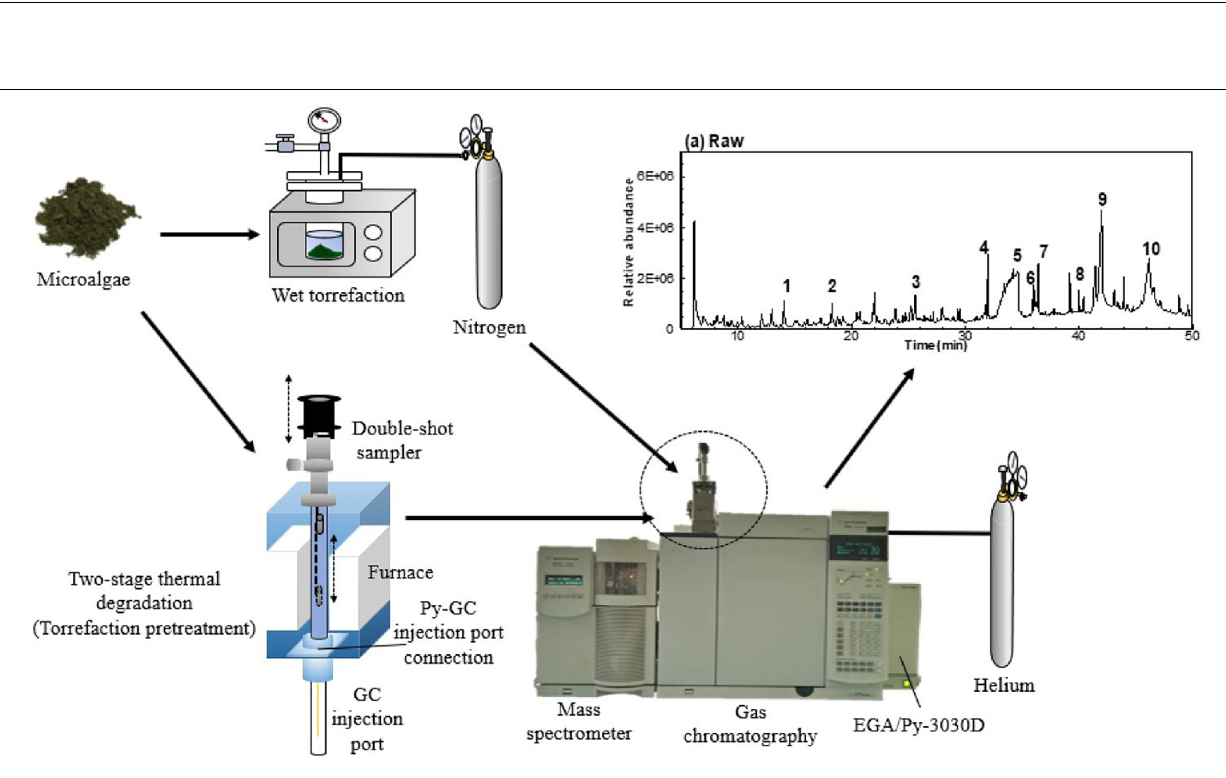
Frontiers in Nutrition |